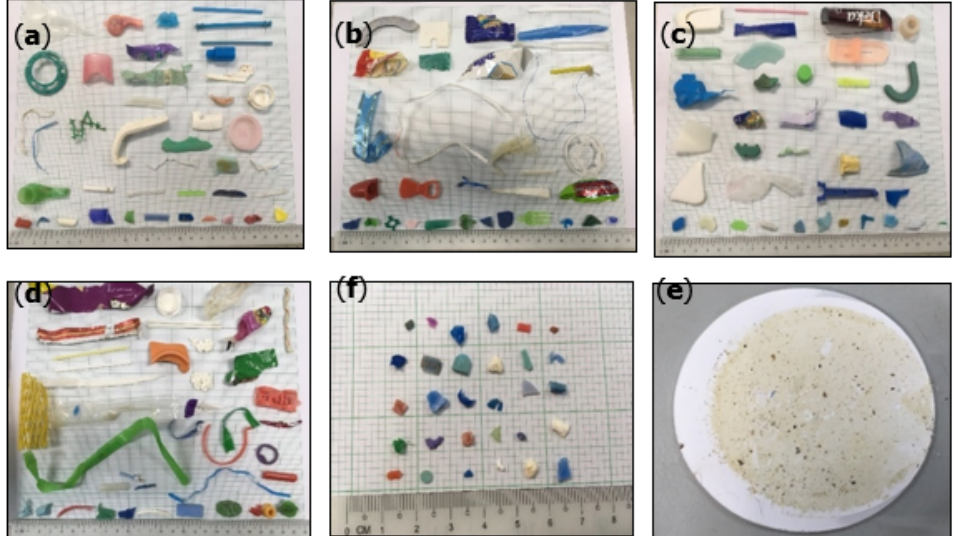
Figure 4. Some of the macro- and mesoplastics that were recovered with the 1 mm sieve, ( a – d ); ( e ) microplastic particles recovered with 1 mm sieve; ( f ) colored microplastics indicated with arrowheads affixed to a filter paper after drying.